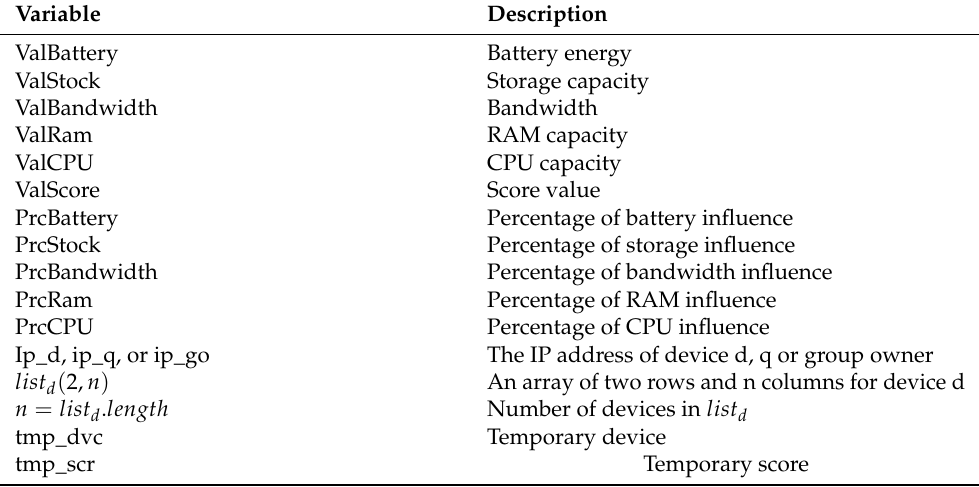
Table 2. The variables of APCAM models and their